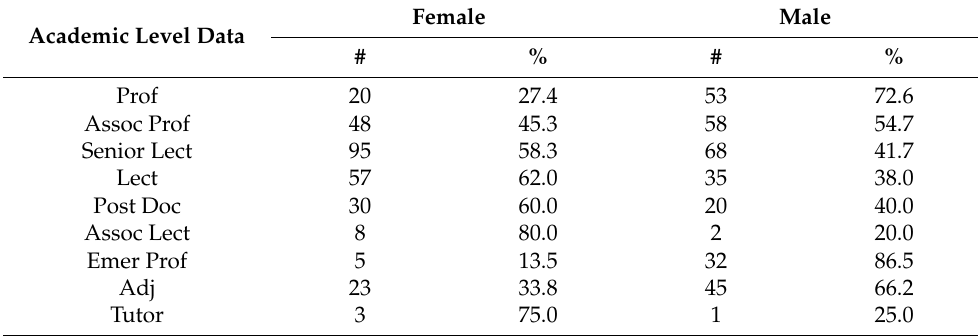
Table 4. Gender distribution across different academic levels in Australia/New Zealand.